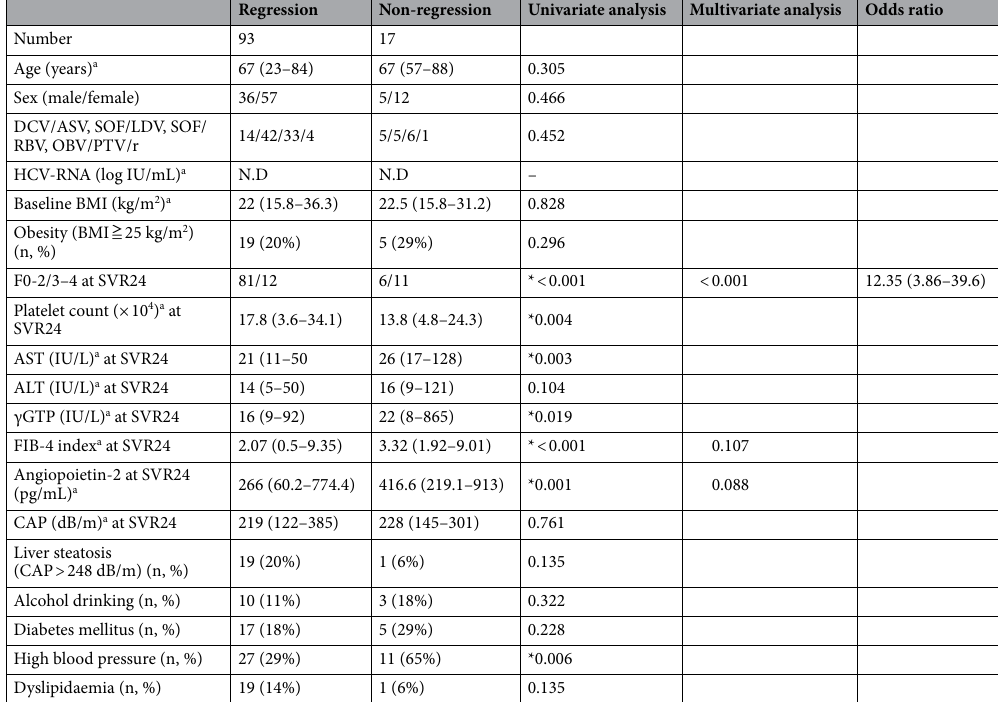
Table 4. Factors associated with non-regression of liver fibrosis stage based on LSM between SVR24 and SVR96 in HCV-infected patients treated with DAAs. HCV hepatitis C virus, BMI body mass index, AST aspartate aminotransferase, ALT alanine aminotransferase, γGTP γ-glutamyl transpeptidase, FIB-4 fibrosis 4, CAP Controlled Attenuation Parameter. a Data are shown as median (range) values. *Statistically significant difference, P < 0.05.